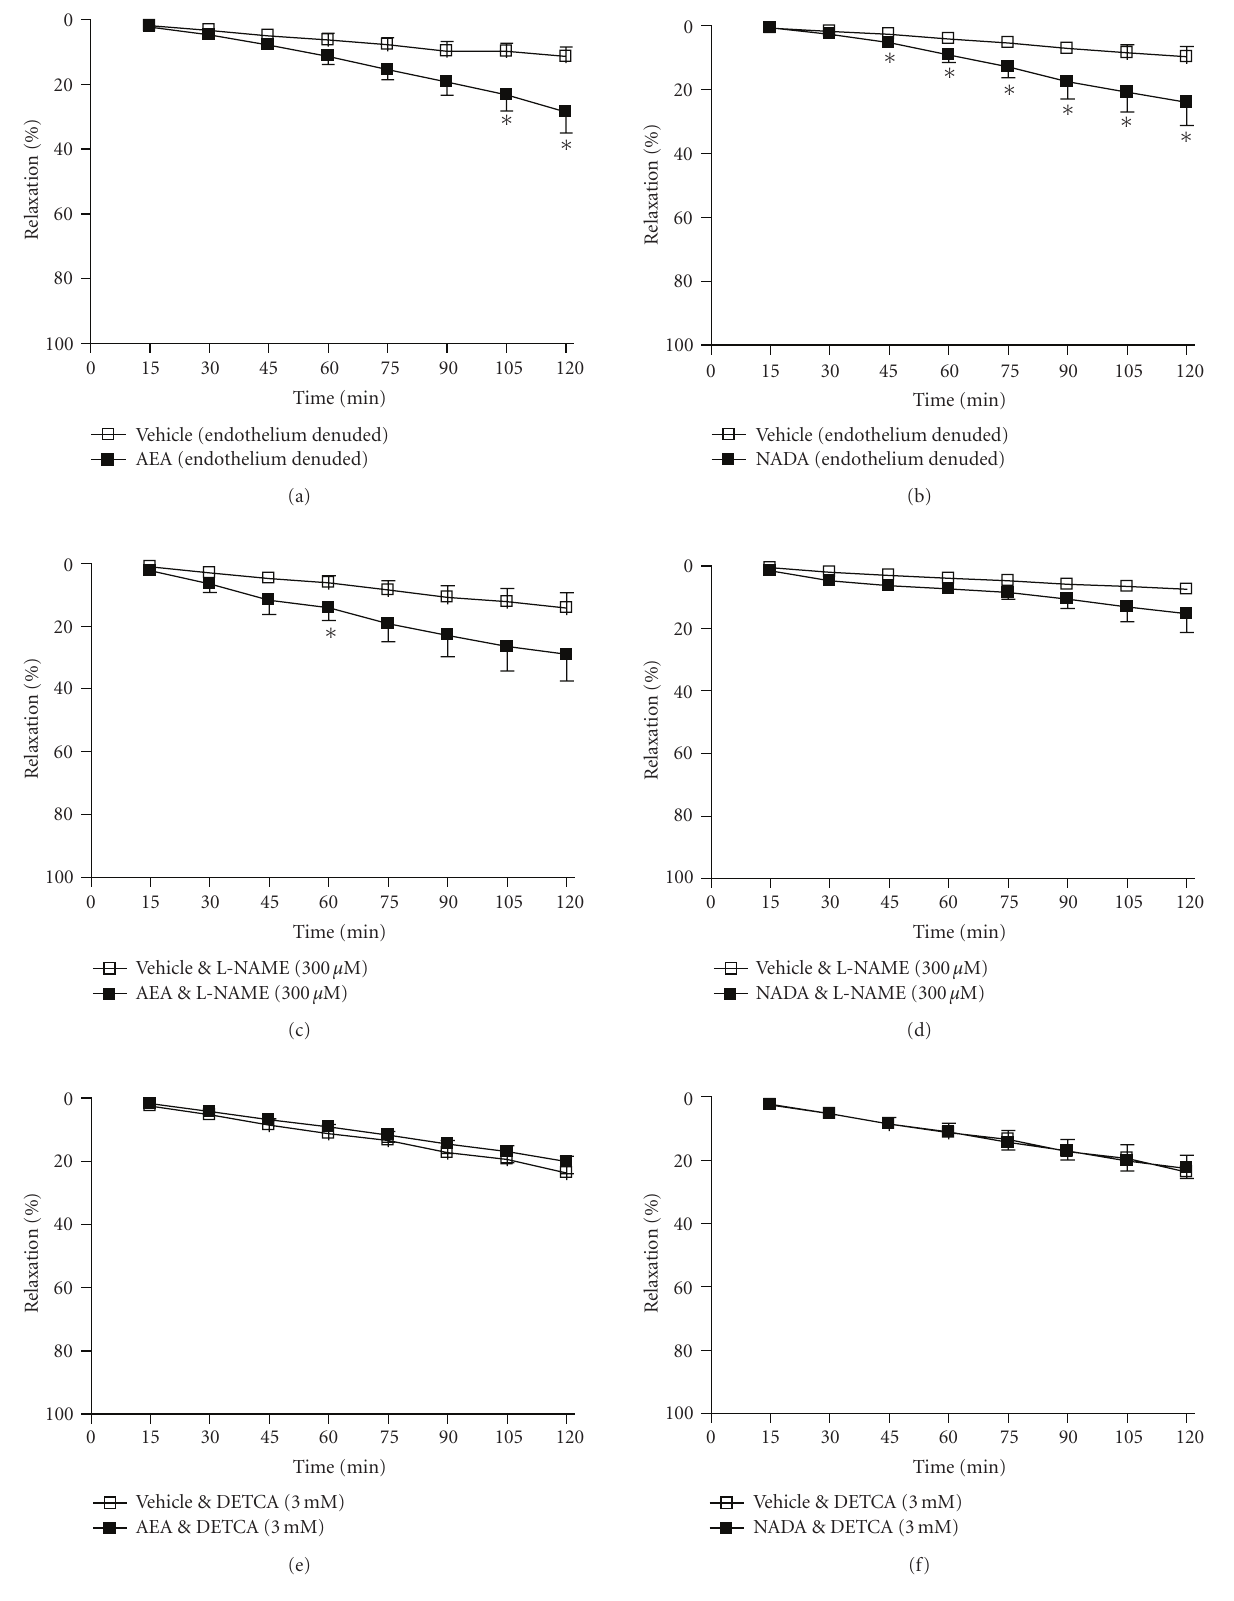
Figure 4: The e ff ects of removing the endothelium ((a), (b)), inhibiting nitric oxide synthase (L-NAME, 300 μ M, (c), and (d)), and inhibiting superoxide dismutase (DETCA, 3 mM, (e), and (f)) on vasorelaxation to anandamide and NADA. Data are given as means with error bars representing SEM. ( ∗ P < . 05, Student’s t